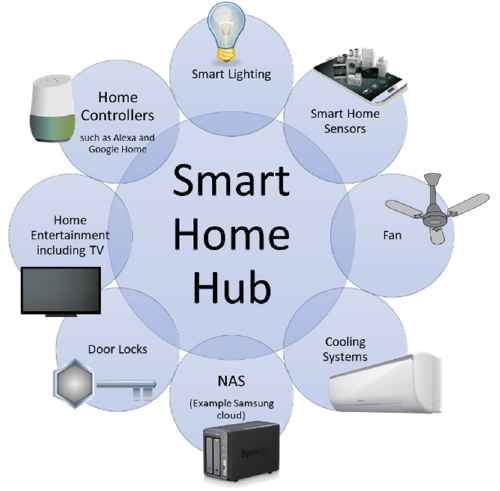
Figure 5. A typical smart home hub in a star topology.